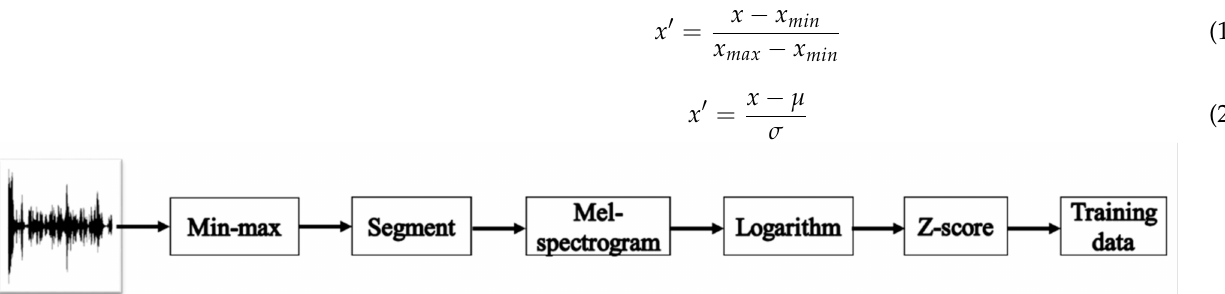
Figure 2. Speech data pre-processing